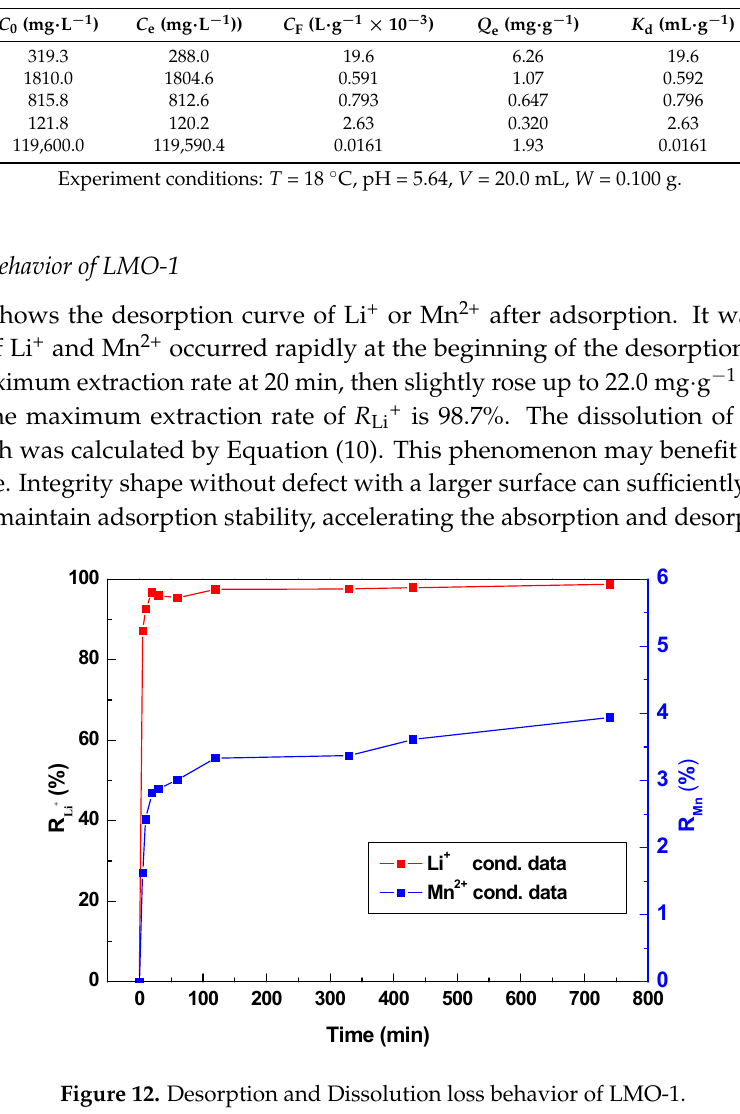
Table 6. Adsorption selectivity data of metal ions on HMO in brine.